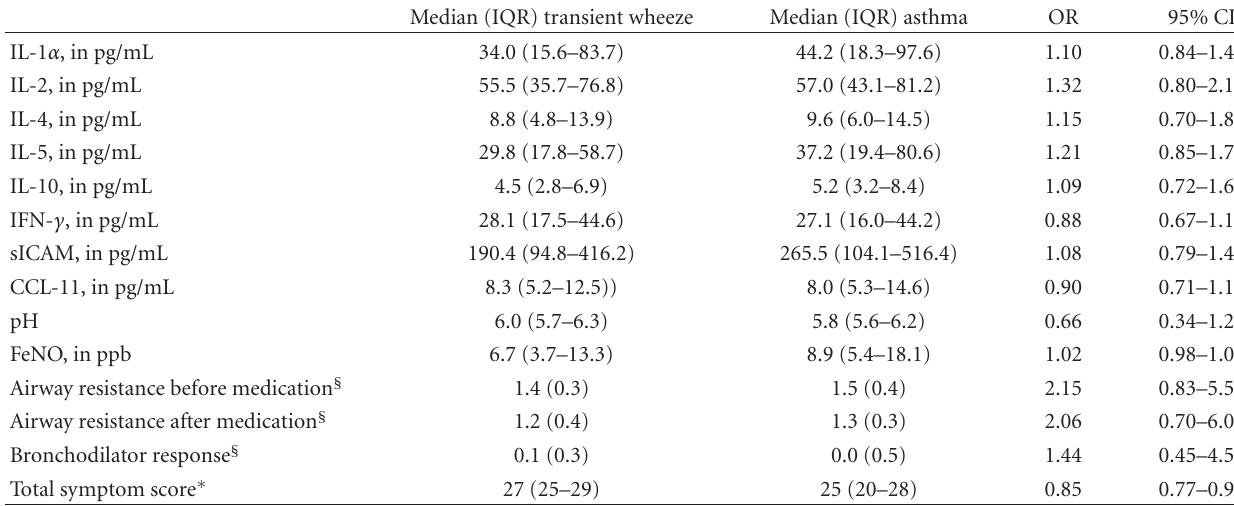
Table 2: Baseline analysis at preschool age.